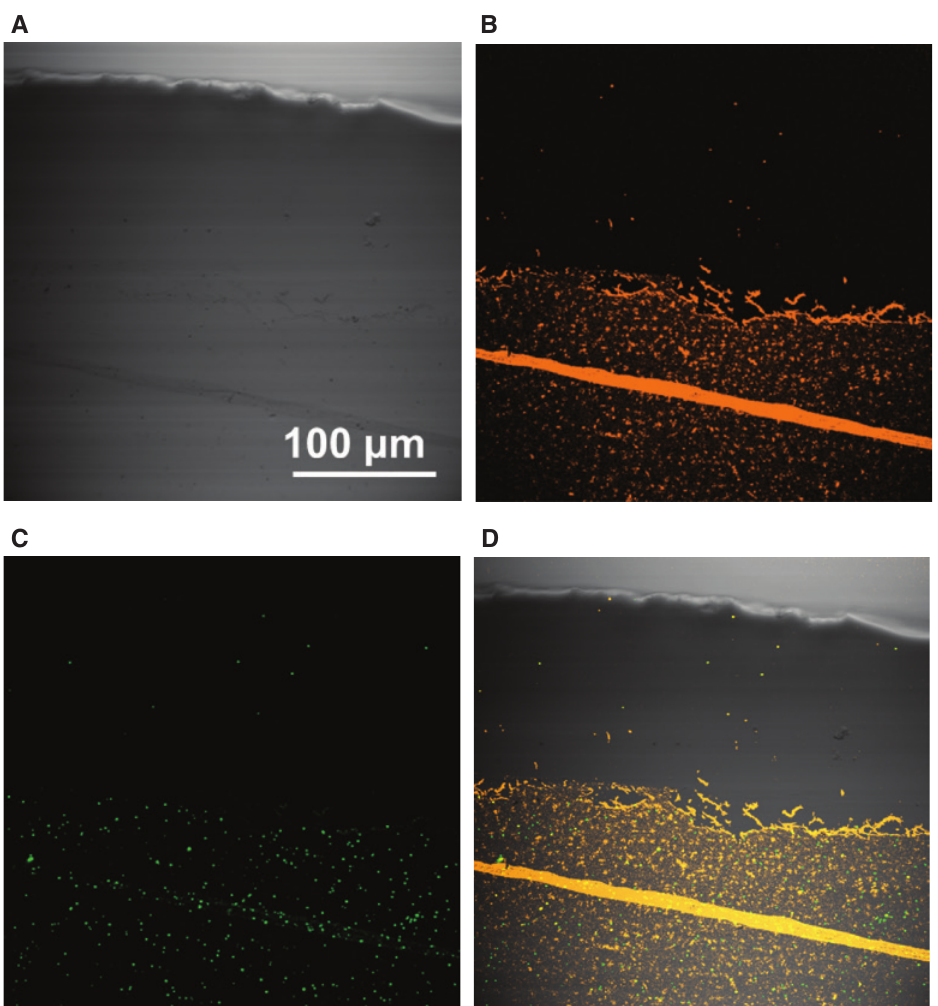
Figure 6: (A) Bright field of monolayer graphene. (B) CARS image of graphene. (C) TPEF + SHG image of graphene. (D) The merged image of bright field + CARS + TPEF + SHG at Raman mode 1560 cm −1